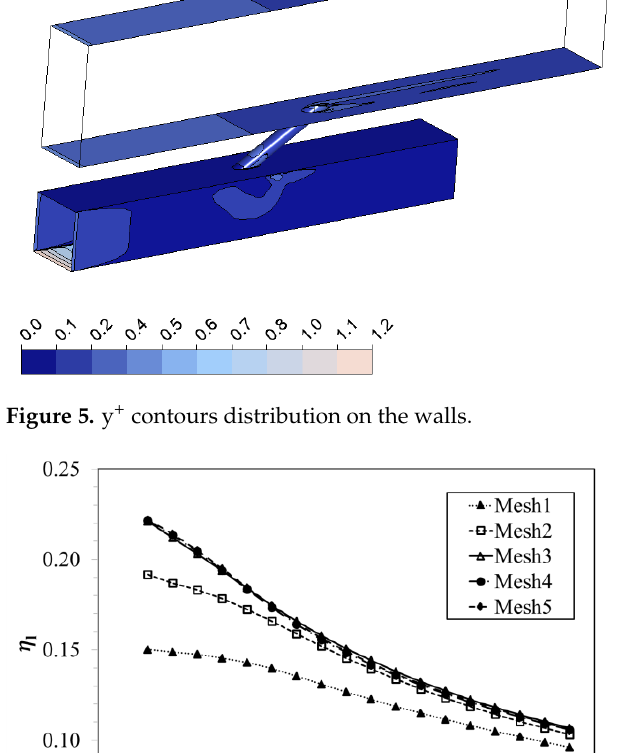
Figure 7. Numerical validation. ( a ) ( b ) Figure 8. Distribution of velocity contours and velocity vectors on x – z plane at y = 0 (unit: m/s): ( a ) velocity contours, ( b ) velocity vectors. 3.2. Expansion Behind the Inlet Hole To reduce the jetting effect, expanding behind the inlet hole is a remarkably effective measure. Figure 9 compares the distribution of 𝜂 𝑠 of the CH and the expanded hole cases. The FE is notably improved by using the flared inlet hole shape. With the 1.5D expanded